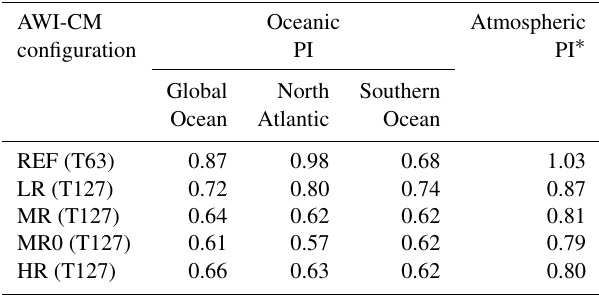
Table B1. Oceanic performance indices (PIs) for the global ocean, two important areas (North Atlantic and Southern Ocean), and key atmospheric